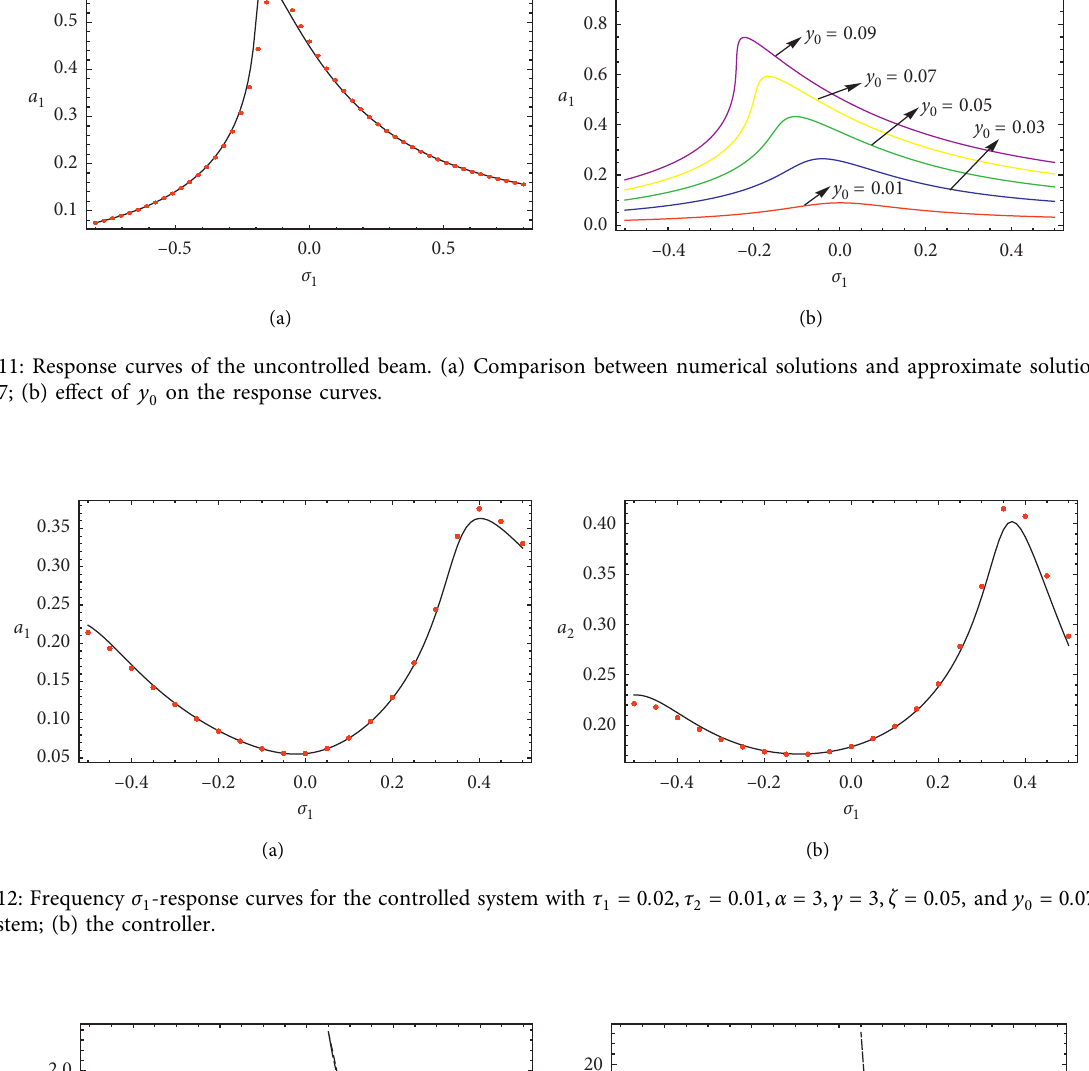
-response curves for the controlled system with τ 1